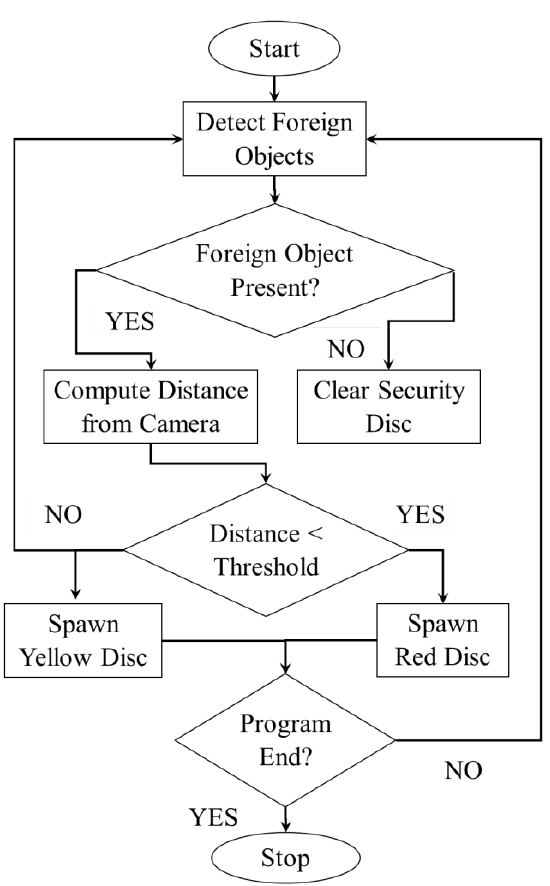
Figure 9. Flowchart algorithm of Safe Human–Machine Interaction.